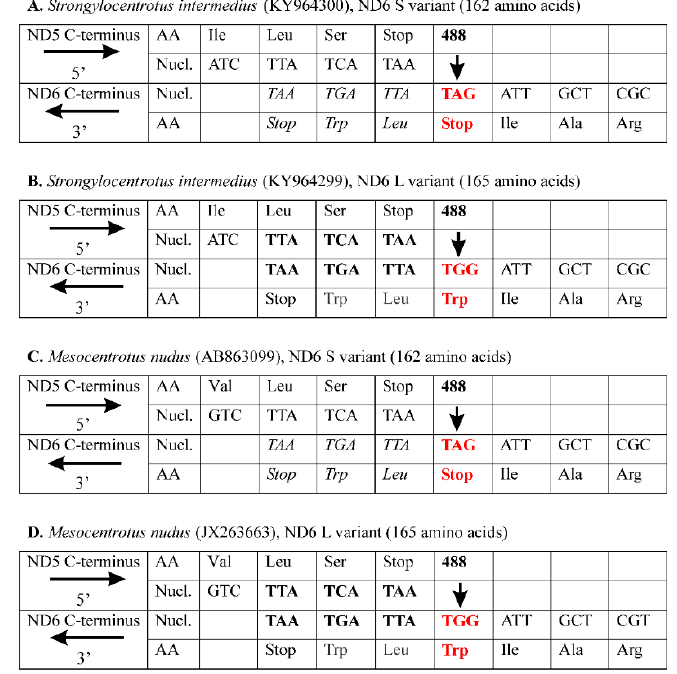
Figure 1. The ND5 and ND6 C-terminus sequences of the sea urchins Strongylocentrotus intermedius ( A , B ) and Mesocentrotus nudus ( C , D ). Conceptual translation of the ND5 and ND6 genes is shown as three-letter abbreviations (echinoderm mitochondrial genetic code). The ND5 gene is encoded on the H-strand, and the ND6 gene is encoded on the L-strand. The strands and corresponding transcripts are denoted by horizontal arrows → (H strand) and ← (L strand). The 5’ and 3’ ends are shown on the left. For the L variant, there is an overlap (highlighted in bold) between ND5 and ND6 encoded on the opposite strand. Nucl. is nucleotides; AA is amino acid residues. The ND6 polymorphic site 488A>G is indicated by bold vertical arrows under the numeral 488; the corresponding codons (TAG and TGG) are highlighted in bold red type indicating the changes in S and L variants. The readthrough extension for the S variants is highlighted in italics.